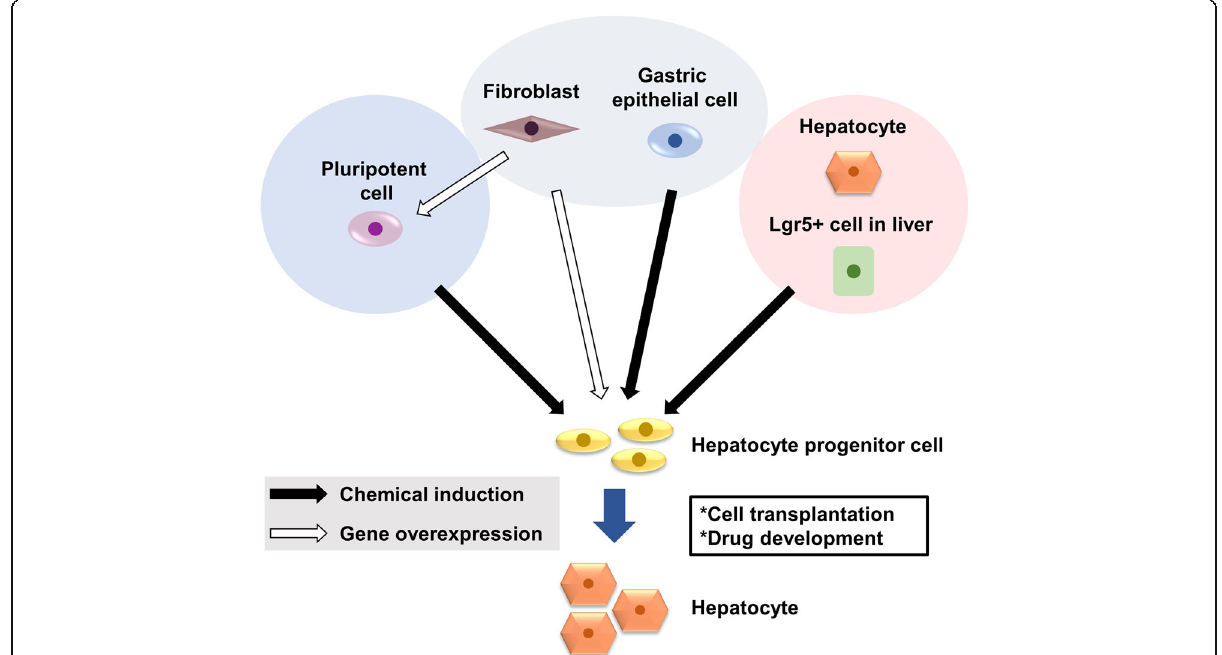
Fig. 1 Approaches to generate hepatocyte progenitors in vitro. Current approaches to generate in vitro-expandable hepatocytes include differentiation of human pluripotent stem cells, reprogramming of fibroblasts and cells of a similar developmental origin, identification of liver progenitor cells, and reprogramming of mature hepatocytes. In vitro-expandable hepatocytes are required as a therapeutic alternative to liver transplantation and for drug